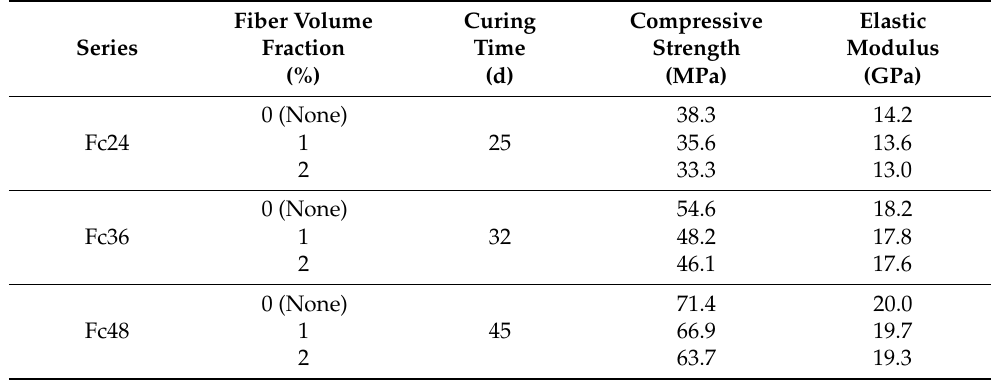
Table 3. Results of compression test.